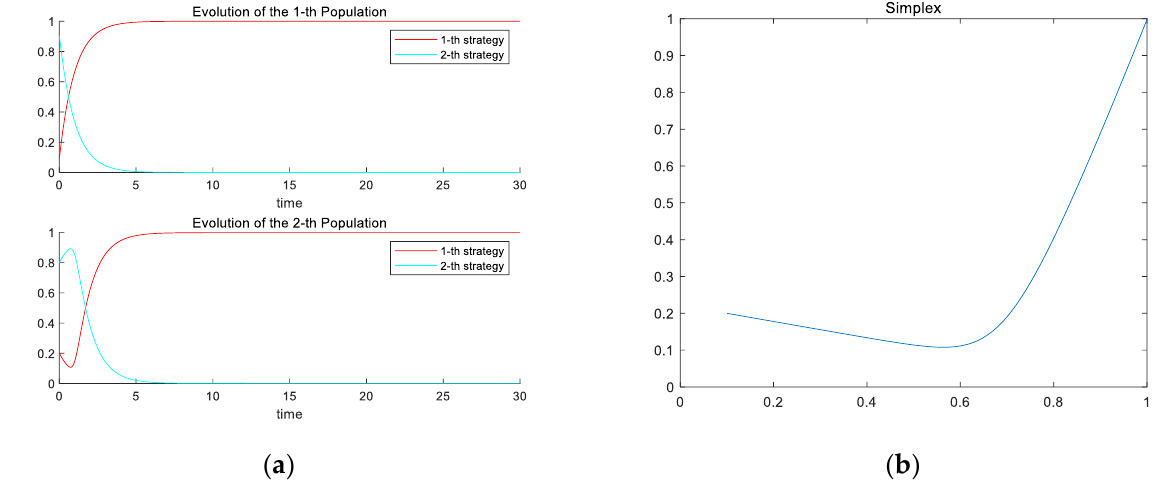
Figure 4. The evolution path of the agent’s strategy described by Proposition 2. ( ( a ) indicates the evolution path of the game strategy; ( b ) describes the stabilization process for a fixed point).